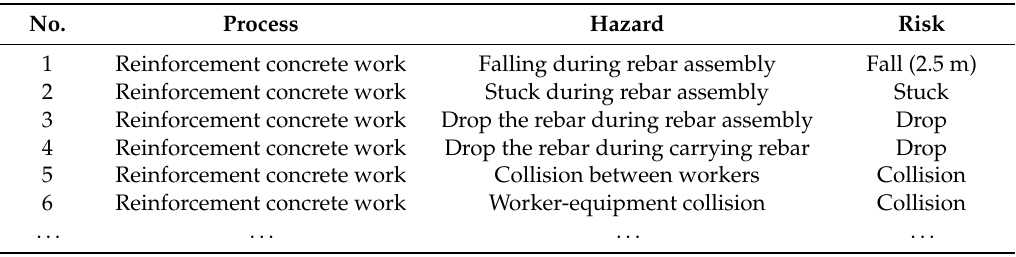
Table 8. Derived risks by hazards for design-for-safety